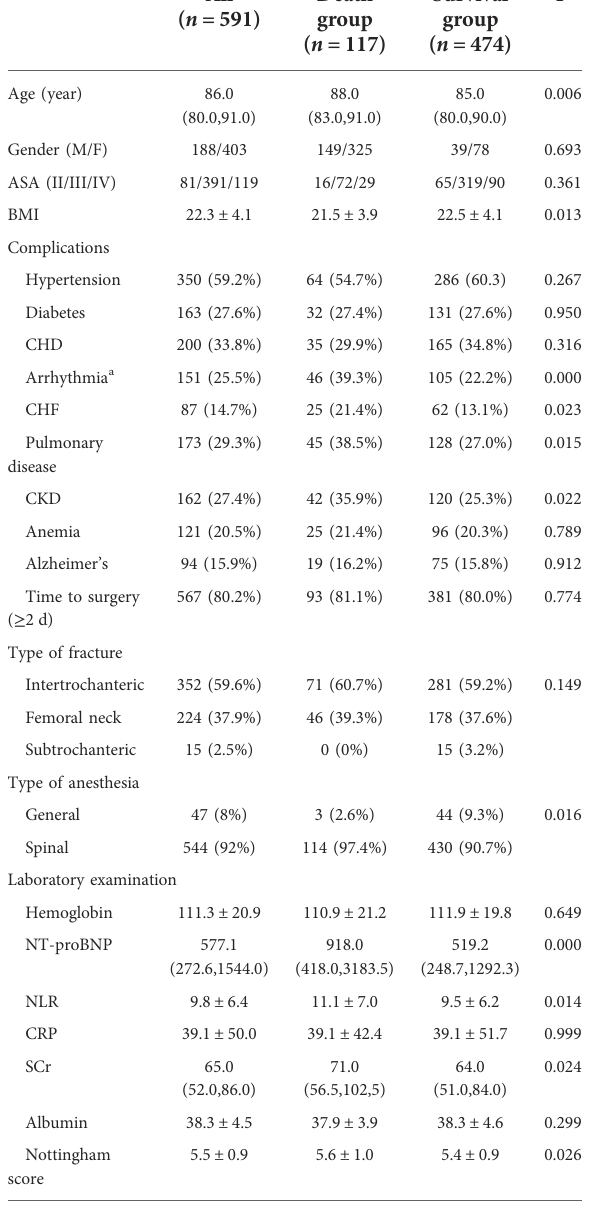
TABLE 1 Characteristics of hip fracture patients classi fi ed by survival status within 1 year.